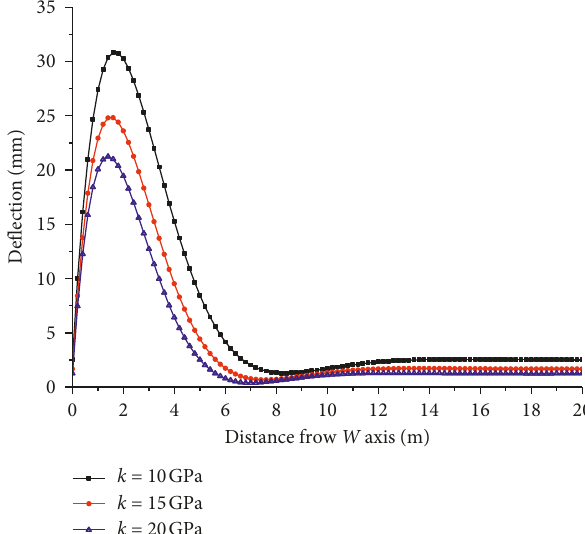
Figure 3: Distribution curves of anticlinal deflection with different tectonic couple.